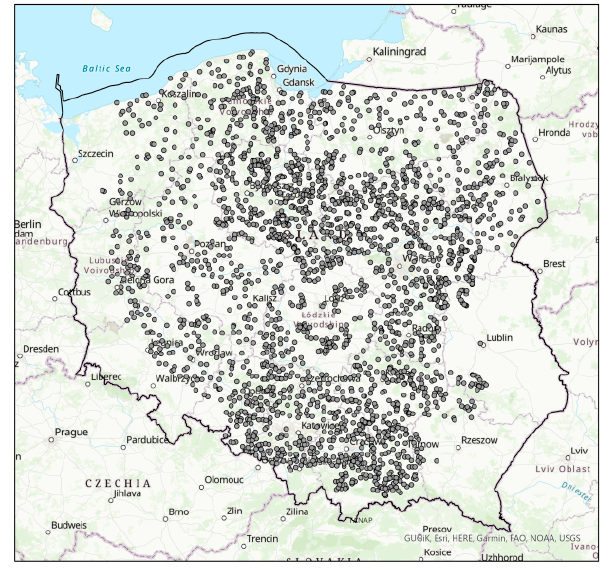
Figure 1. Map of the study and sampling area.